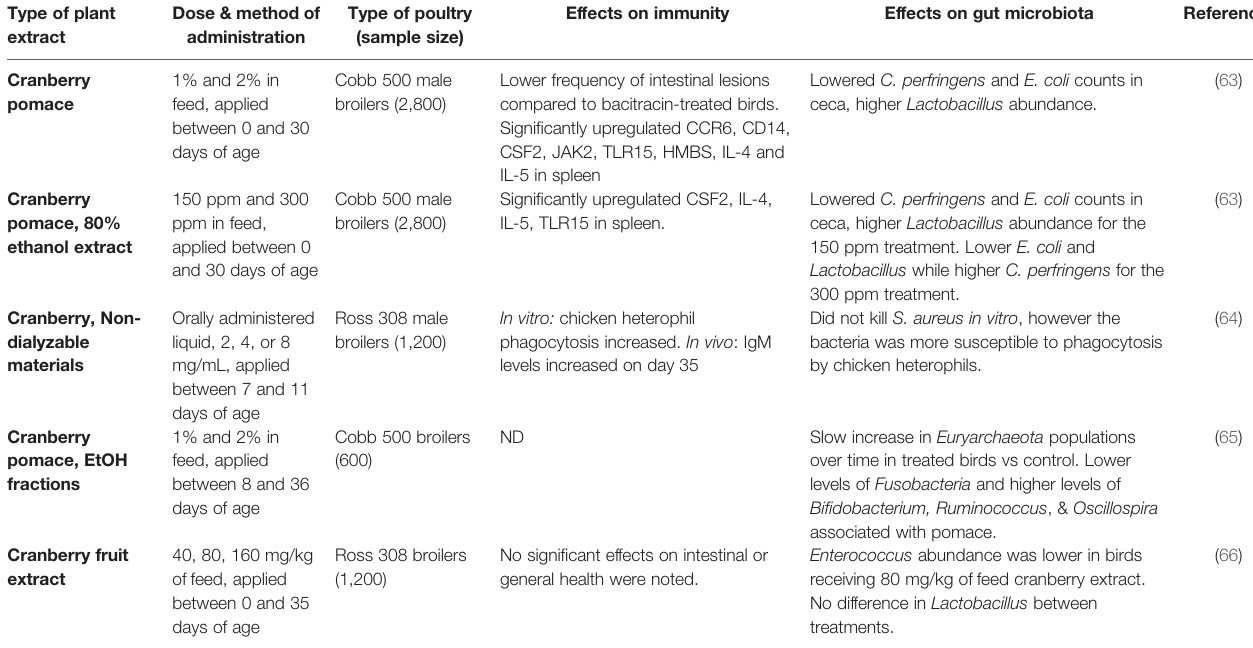
TABLE 3 | A comparison of in vivo feeding studies of cranberry byproducts and extracts in poultry, highlighting signi fi cant effects on the immune system and gut microbiota in live chickens.